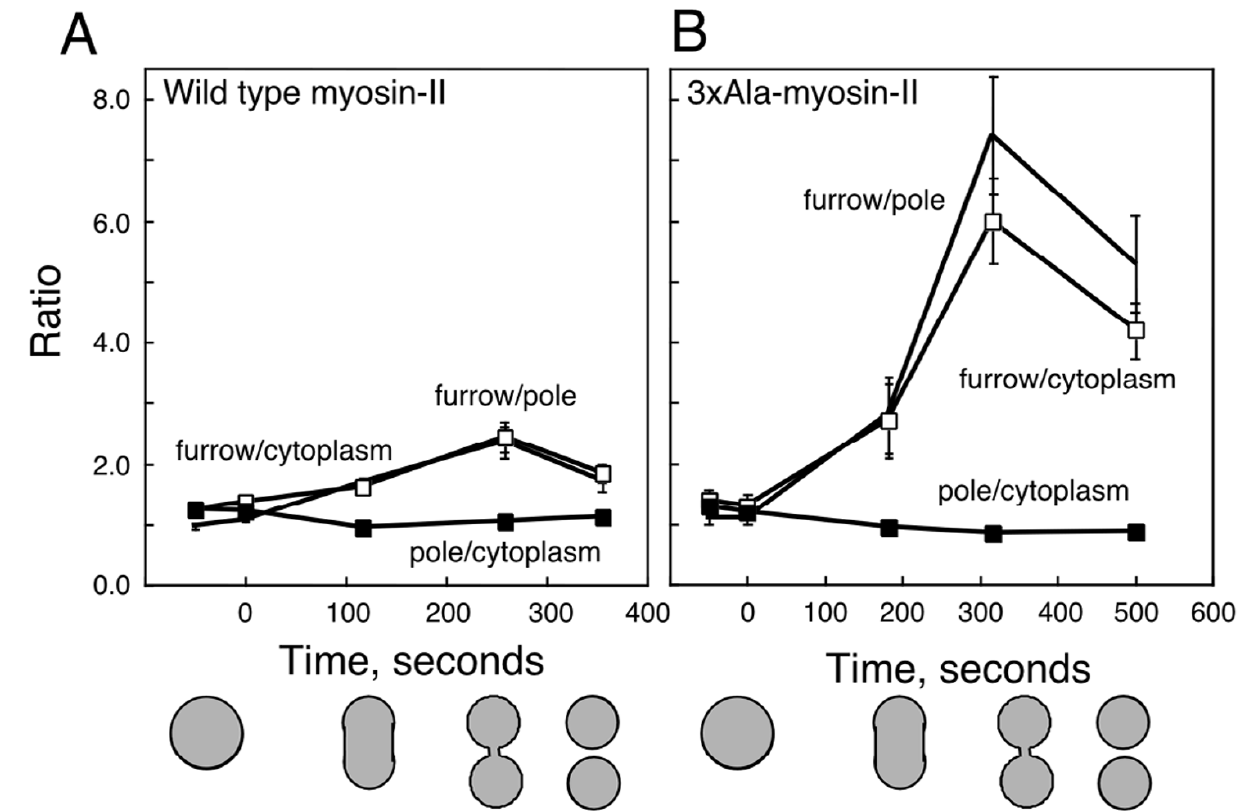
Figure 3 The relative intensity ratios for the pole cortex, furrow cortex and cytoplasm were measured as a function of time. Zero sec- onds indicates the point of nuclear division. A. The graph shows the ratios obtained with wild-type GFP-myosin-II. The shapes of the cells at four different time points are indicated by the cartoons. B. This graph shows the ratios obtained with cells expressing 3 × Ala GFP-myosin-II. Standard errors for each time point are based on n ≥ 4. Markers: furrow-to-pole, no marker; furrow-to-cytoplasm, open square; pole-to-cytoplasm, closed square. The same markers are used for both